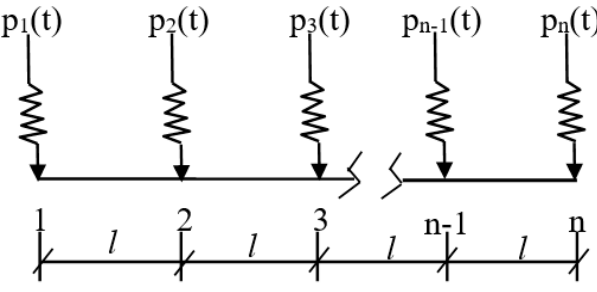
Figure 7. Schematic diagram of dynamic load application.